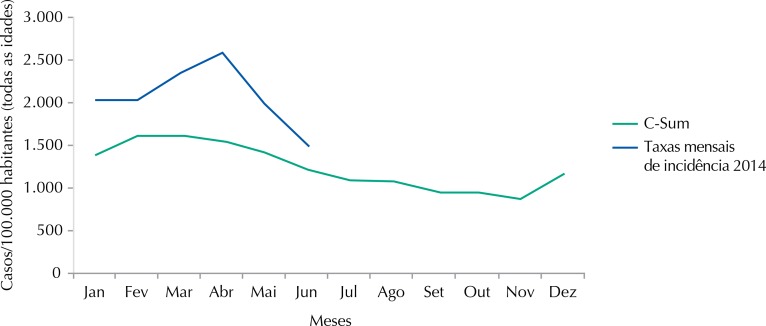
Canal endêmico 2009-2013 (todas as idades) pelo método C-Sum e taxas de incidência mensais registadas em 2014 (todas as idades), Moçambique.